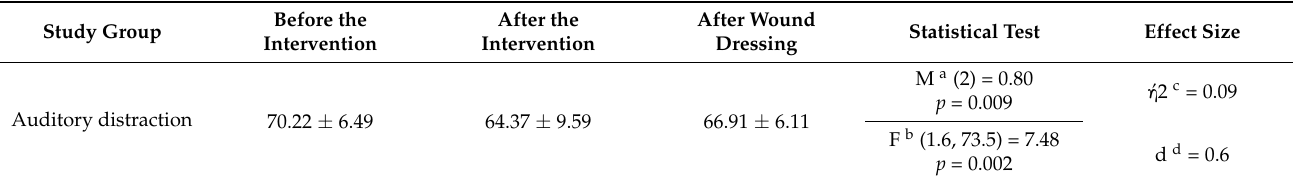
Table 3. Comparison of the mean scores of pain anxiety between the groups ( n =